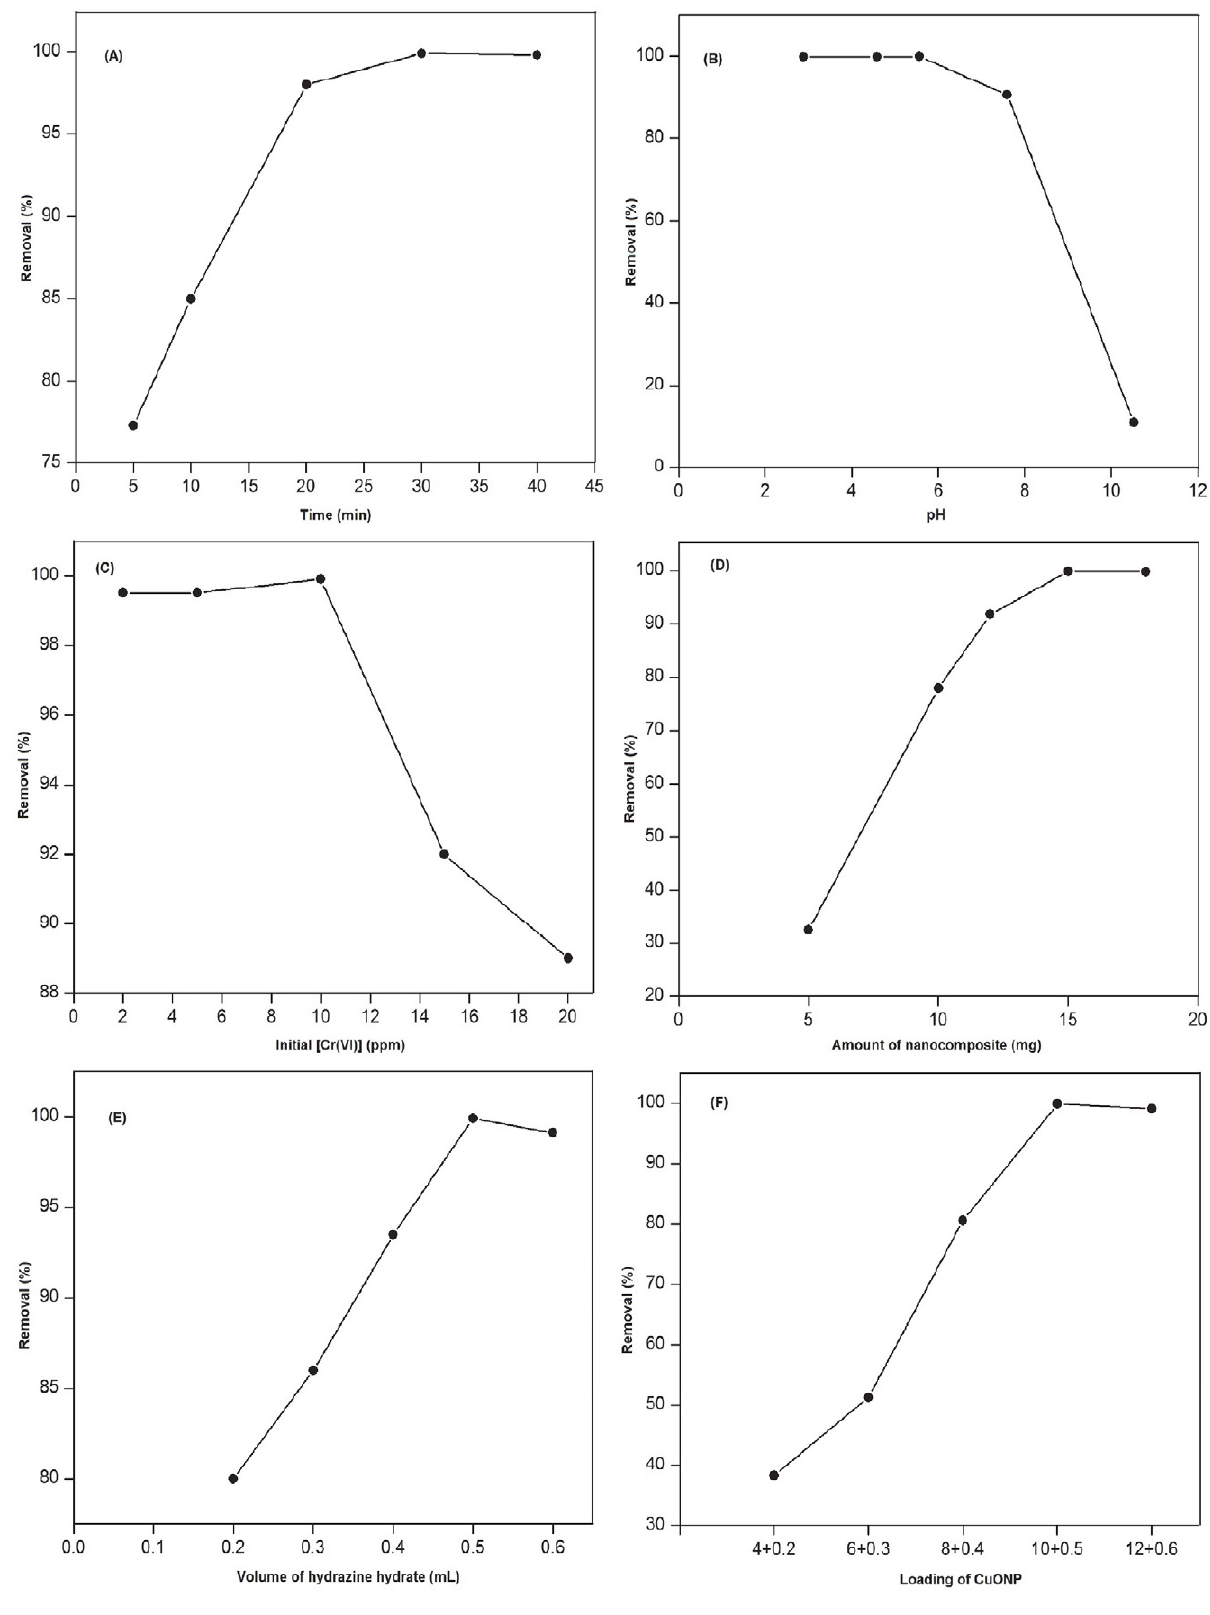
Figure 2: Effect of various factors on the removal of Cr(VI) (A) Duration of experiment, (B) pH (C) Initial Cr(VI) concentration (D) Amount of nano-composite (E) Volume of hydrazine hydrate (F) Loading of CuONP on the